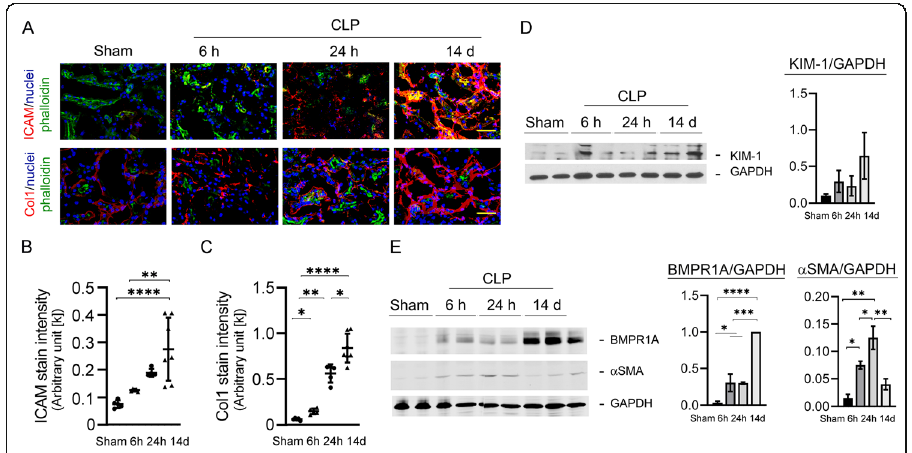
Fig. 1 SA-AKI non-recovery and treatment timing. A pro-fibrotic S-AKI outcome at 2 weeks post the initial insult. Sepsis was induced by cecal ligation and puncture surgery (CLP) and the renal expressions of injury markers were shown. a – c Representative images of renal intercellular adhesion molecule (ICAM) and collagen type I (Col1) staining and the expression intensities for group animals (mean ± SD, N = 6~7). Scale bar = 30 μ m. d – e Blots of kidney injury marker expressions and the corresponding intensities of the blots. Tukey ’ s test